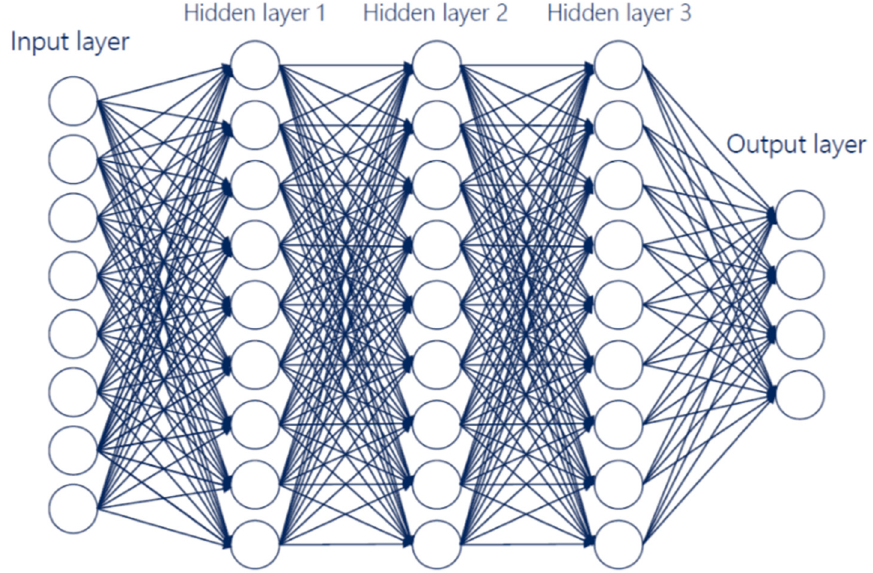
Figure 2. Deep Neural Network (DNN) example.